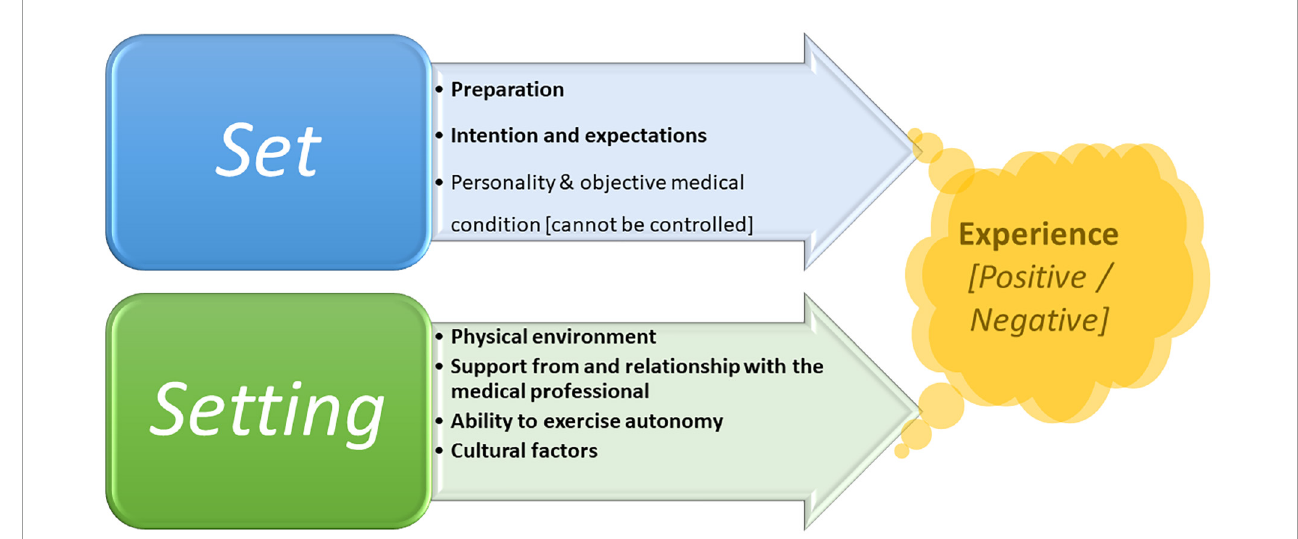
FIGURE3 Set and setting parameters that shape both psychedelic and birth